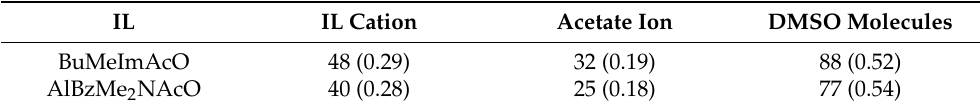
Table 5. Averaged number of chemical species (IL + , AcO − , and DMSO) inside the first solvation shell of SF crystal for both simulations a .